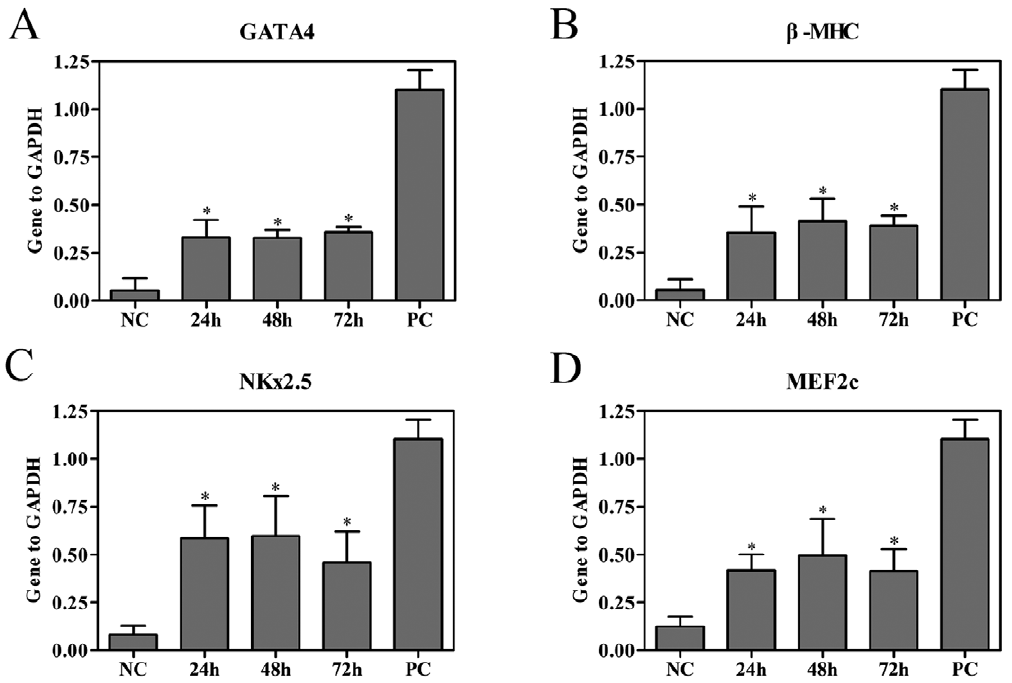
Figure 3. Effects of the duration of strain on the cardiac-related gene expressions of rBMSCs. rBMSCs were cultured under static conditions or exposed to cyclic strain of 10% at a frequency of 1 Hz for 24, 48 and 72 h and mRNA expression levels of GATA-4, b -MHC, NKx2.5 and MEF2c were assessed on the 7 th day by quantitative real-time RT-PCR analysis. The expression of each gene was normalized based on the expression of GAPDH. (A) GATA4. (B) b -MHC. (C) NKx2.5. (D) MEF2c. NC, negative control (rBMSCs treated with regular complete medium); PC, positive control (normal neonatal rat cardiomyocytes). Results are shown as the mean 6 SD values (n=4). * P , 0.05 compared to the NC group.